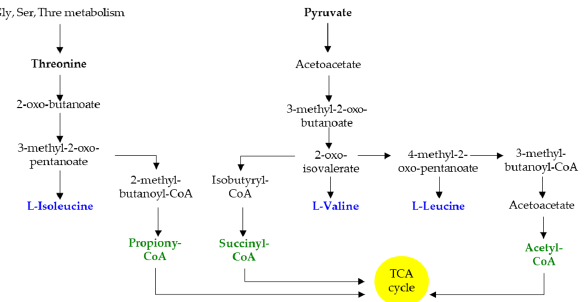
Figure 3. Schematic representation of BCAA and BCFA biosynthesis. Gly, glycine; Ser, serine; Thre, threonine.